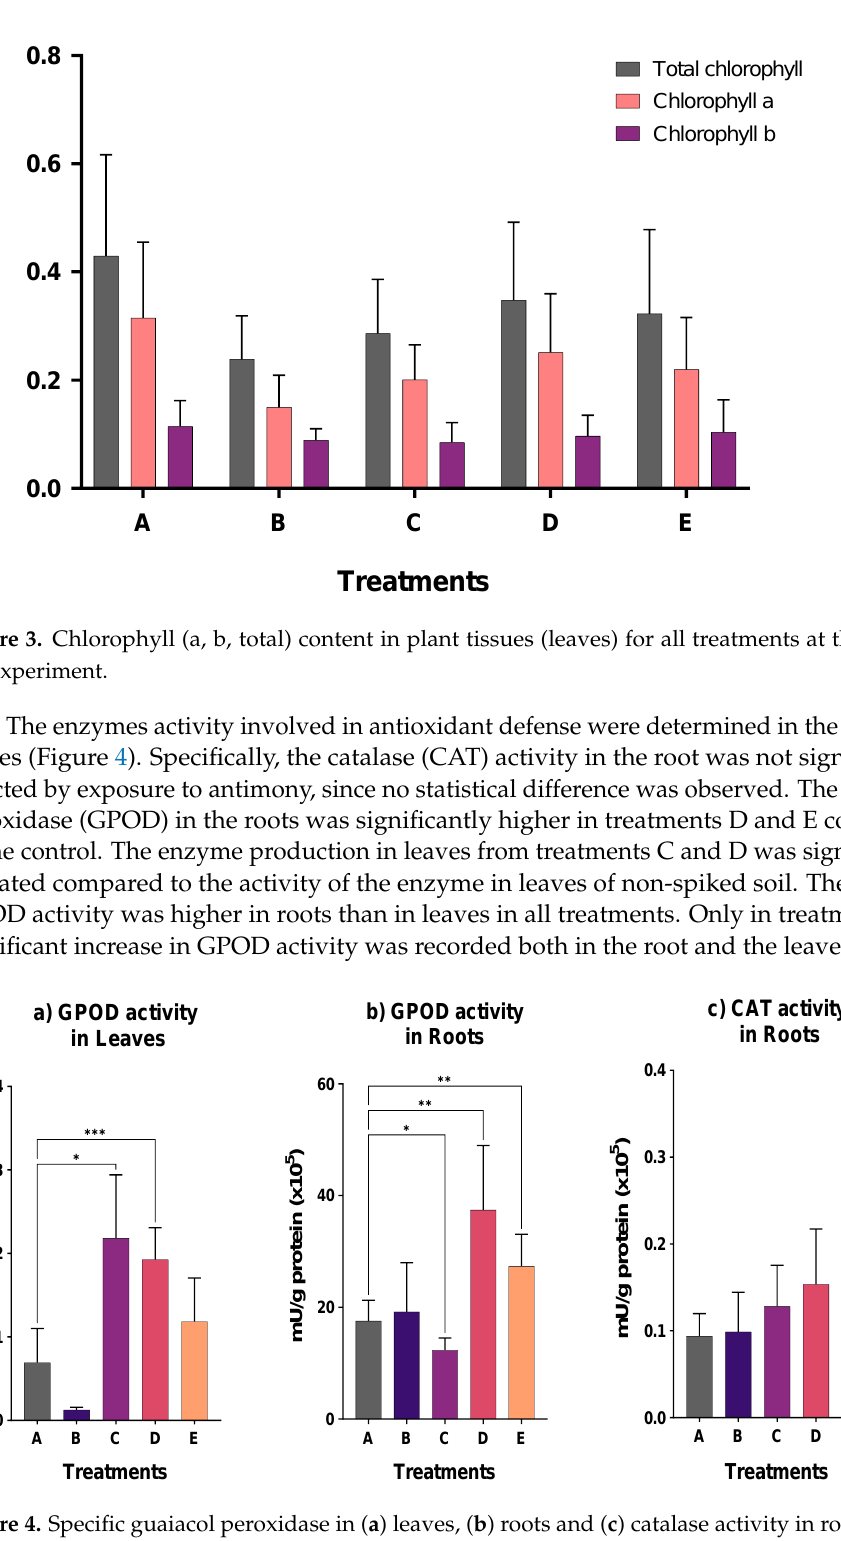
b ) W a t e r c on t e n t ✱✱ ✱✱✱ ✱✱✱✱ Figure 2. Loss of weight and water content at the end of the experiment for all treatments (star indicates the level of significance: ** for p < 0.01, *** for p < 0.001). Regarding total chlorophyll, chlorophyll a, and chlorophyll b, statistically significant differences compared to the control were not found for all treatments. As shown in Figure 3, the chlorophyll content (mg/g FW) was the highest in the control, while the lowest was